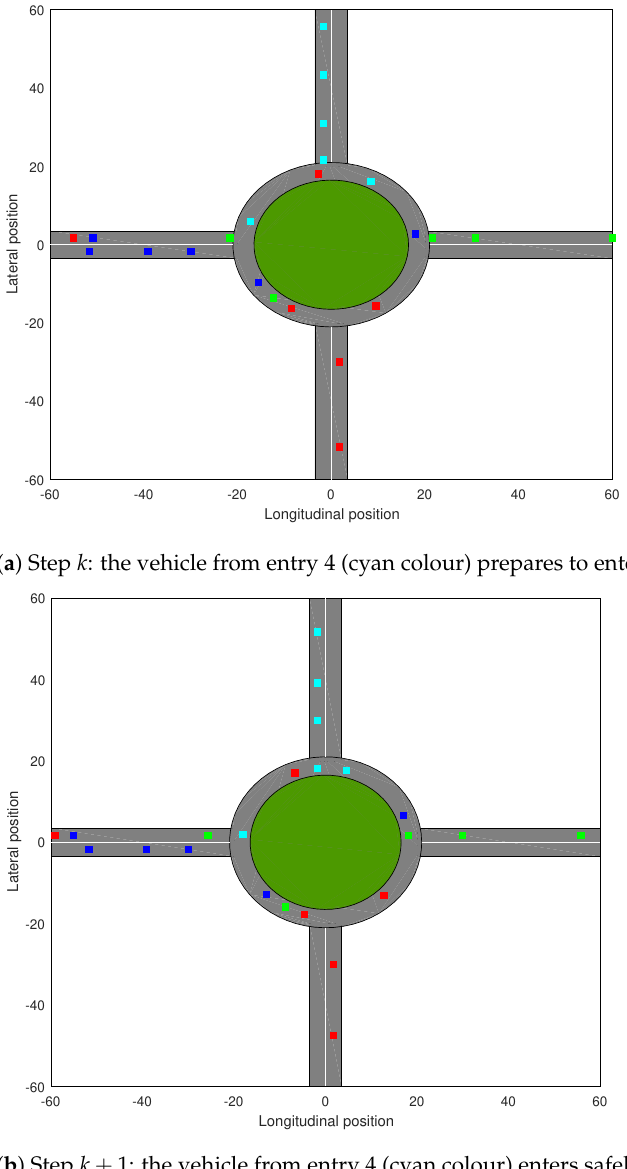
Figure 4. Entry 4—simulation detail